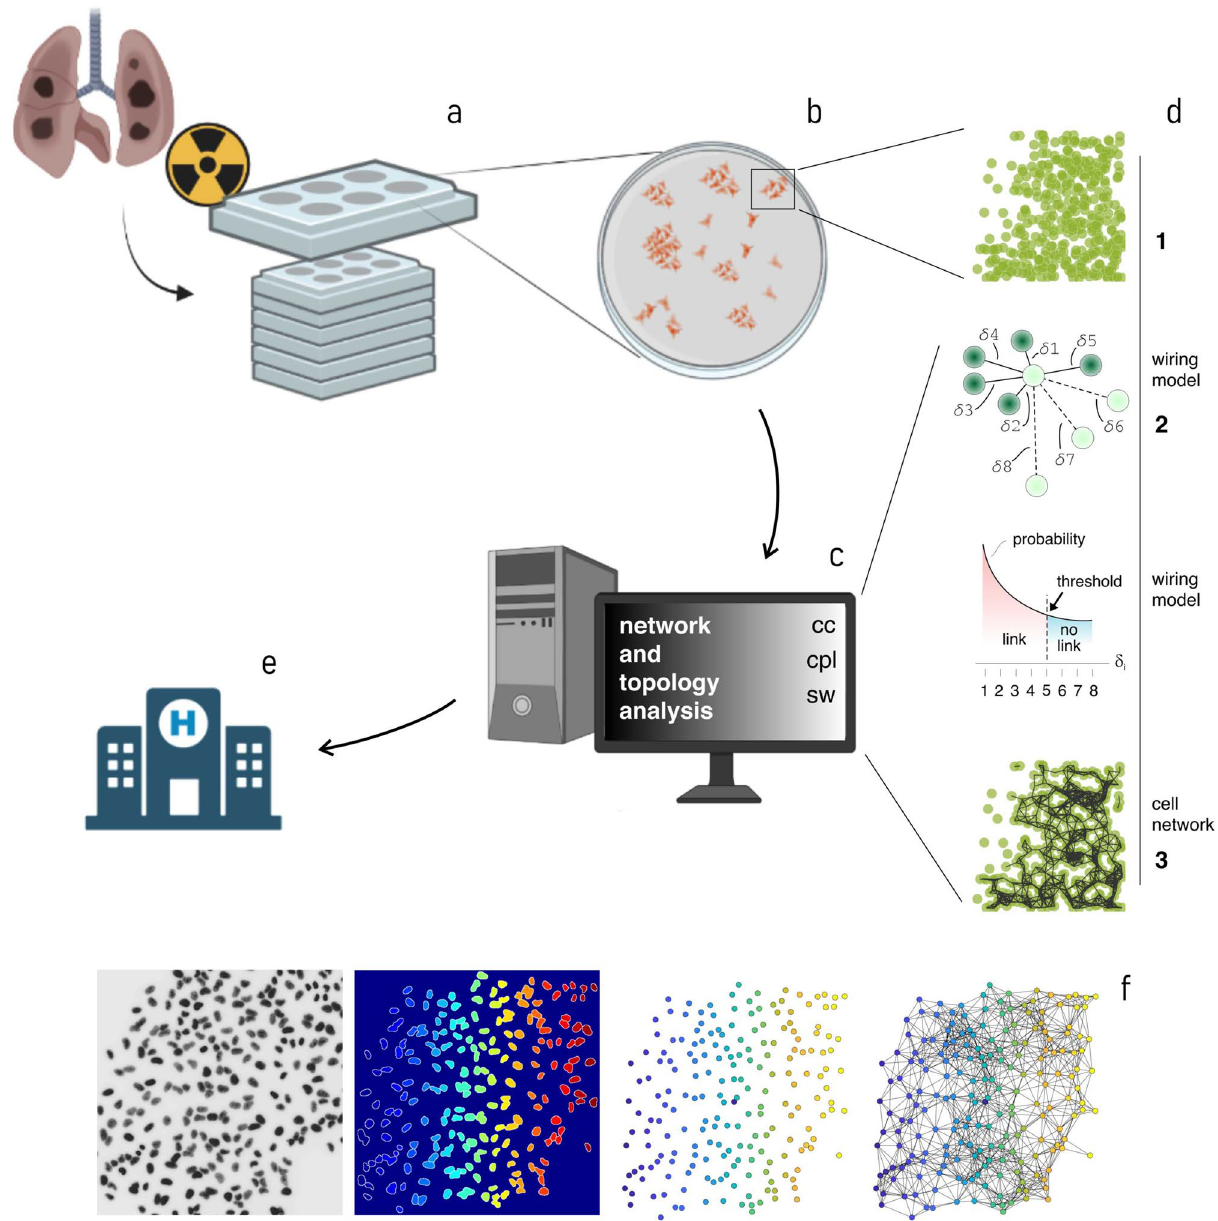
Figure 1. Flowchart of the different steps of the study. Different lung cancer cells (H460, A549 and Calu-1) were cultured on a 6-multi-well plate and exposed to an ionizing radiation in the 0–8 Gy range ( a ). Cells were then images using fluorescence microscopy ( b ). The acquired images were then passed to a computer for processing and data analysis ( c ). The data analysis consisted in well-assessed technique of network science, including: routing the nodes, building the associated cell graphs, and extraction of network parameters such as the clustering coefficient, the characteristic path length, and the small world coefficient ( d ). The topological parameters determined through the analysis where then correlated to the biological characteristics of cells and the radiation dose. This procedure and the association between the topology of cancer cell graphs, the radiation, and the cell characteristics, can be possibly used in clinical medicine as a method for determining the radioresistance of cells and the performance of radiotherapy ( e ). Part ( f ) of the figure illustrates how graphs were generated out of cells. The originating fluorescent cell images were segmented and isolated by a watershed transformation and a distance transform. The process enabled to split out separated, non-touching regions in each image that were thus identified as the cell-centers. Cell centers were then connected using the Waxman’s model: the Waxman algorithm finds the probability of two nodes being linked as a negative exponential function of their distance. (Partially created with